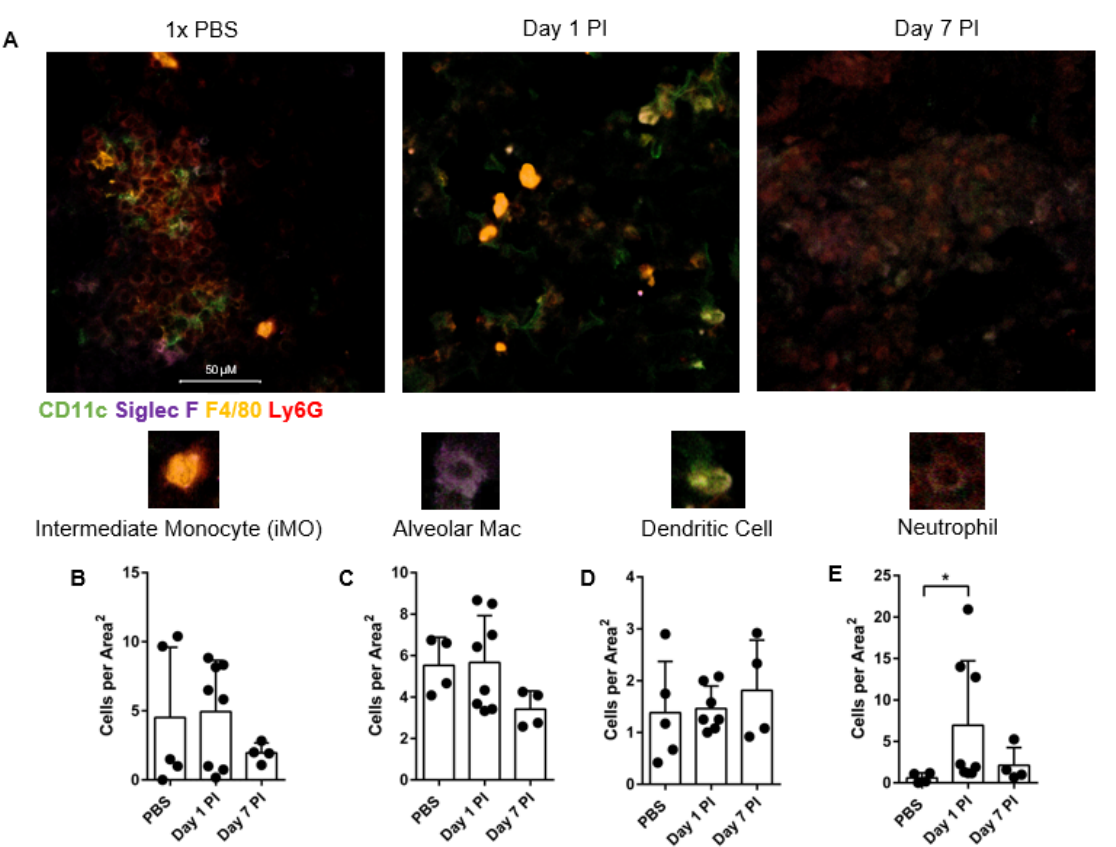
Figure 4. Immunohistochemistry and lung image scoring reveals heightened CD11c positive and Ly6G positive cells in the lung post infection. Lungs were processed at day 1 and day 7 post infection (PI) and fresh-frozen. ( A ) In the representative plot, PBS is the mock infection whereas Day 1 and Day 7 show 10 5 arthroconidia intranasal infection at 40 × confocal imaging. 50 µ M scale bar applies to all images. ( B ) Intermediate monocytes (iMO) are defined as F4/80+ Ly6G+, ( C ) alveolar macrophages (Mac) as F4/80+ CD11c+ Siglec-F+, ( D ) DCs as CD11c+ F4/80 − , and ( E ) neutrophils as Ly6G+ F4/80 − CD11c − . Images scored are from 40× magnification. Each image represents 742,819.8969 uM 2 in Area 2 , calculated from square image of 862 × 862 µm 2 . Images were blind scored by two independent counters. For all plots displayed line indicates mean, and each dot is one experimental replicate for each lung sample averaged over 5 images and two blind-scorers. n = 4–7, representative of 4 experiments. Comparisons were made between mock PBS infection and infected at each time point. Data was analyzed using unpaired Student’s t -test and outliers excluded using Grubbs Outlier exclusion analysis; * p < 0.05.